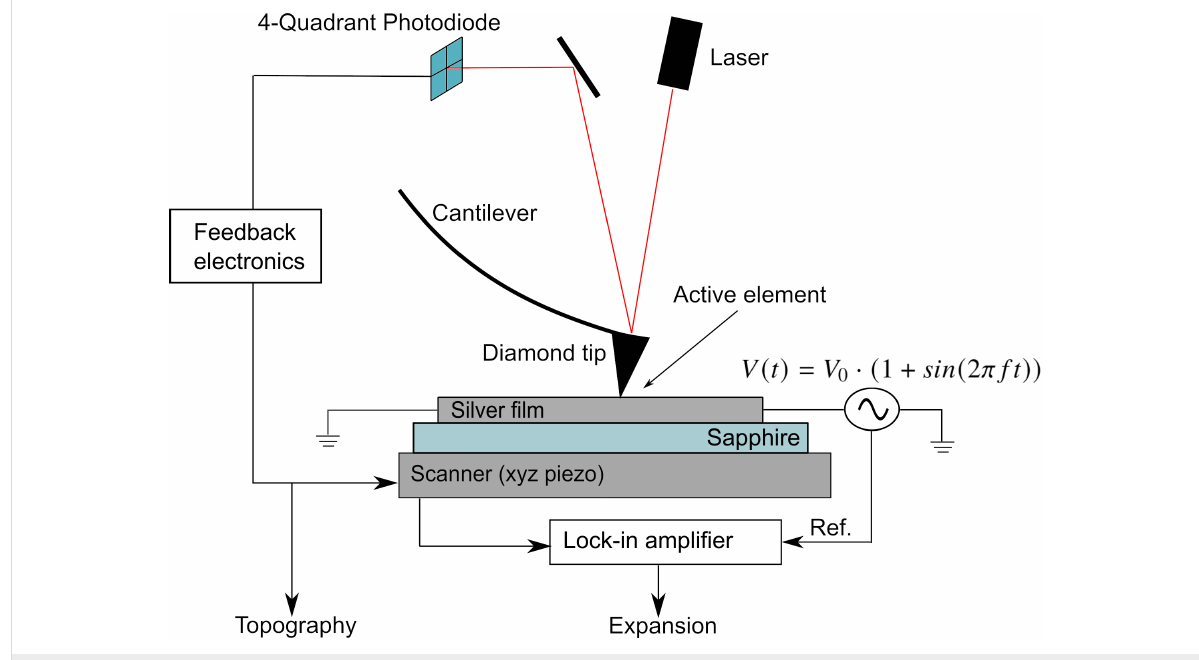
Figure 3: Schematic describing the experimental setup used to perform SJEM measurements on a modulated